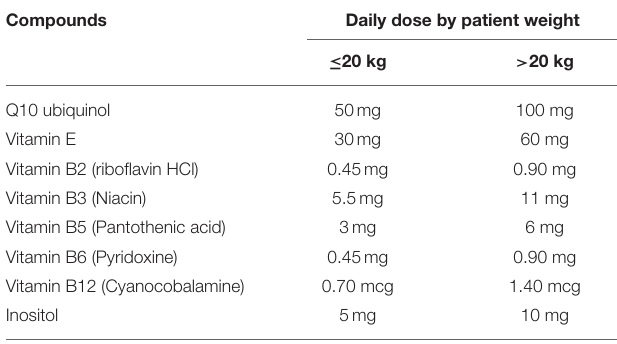
TABLE 1 | Composition of the “metabolic support therapy”.